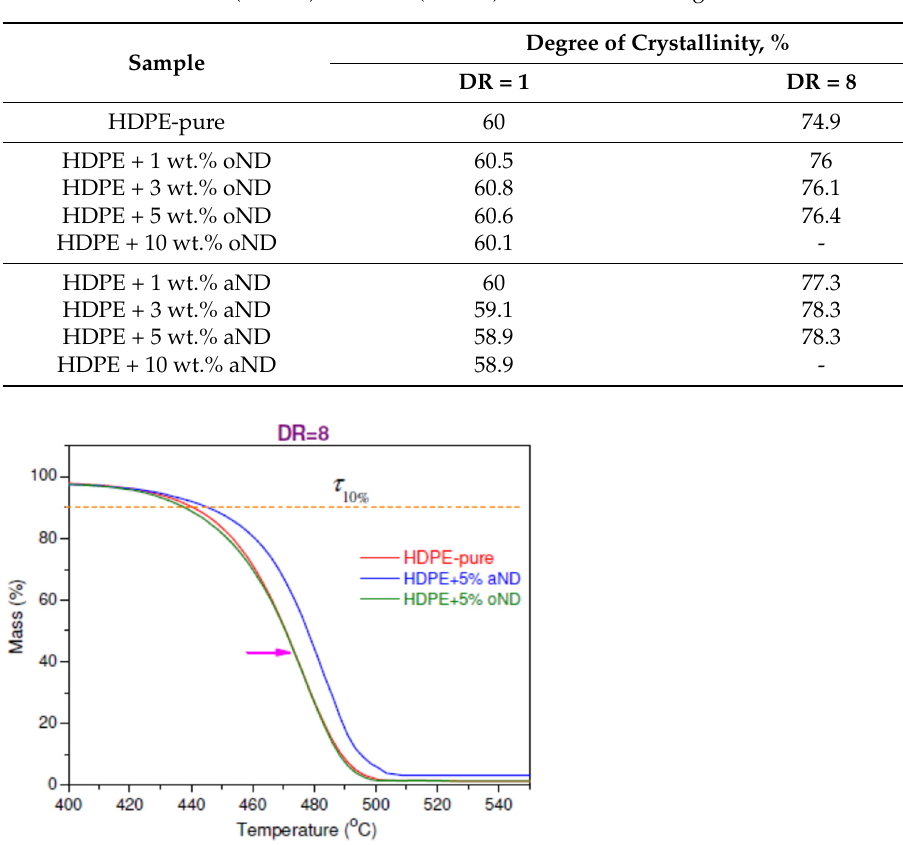
Table 2. Dependence of the degree of crystallinity ( χ ) on the filler content in the composite fibers based on HDPE before (DR = 1) and after (DR = 8) orientation drawing.